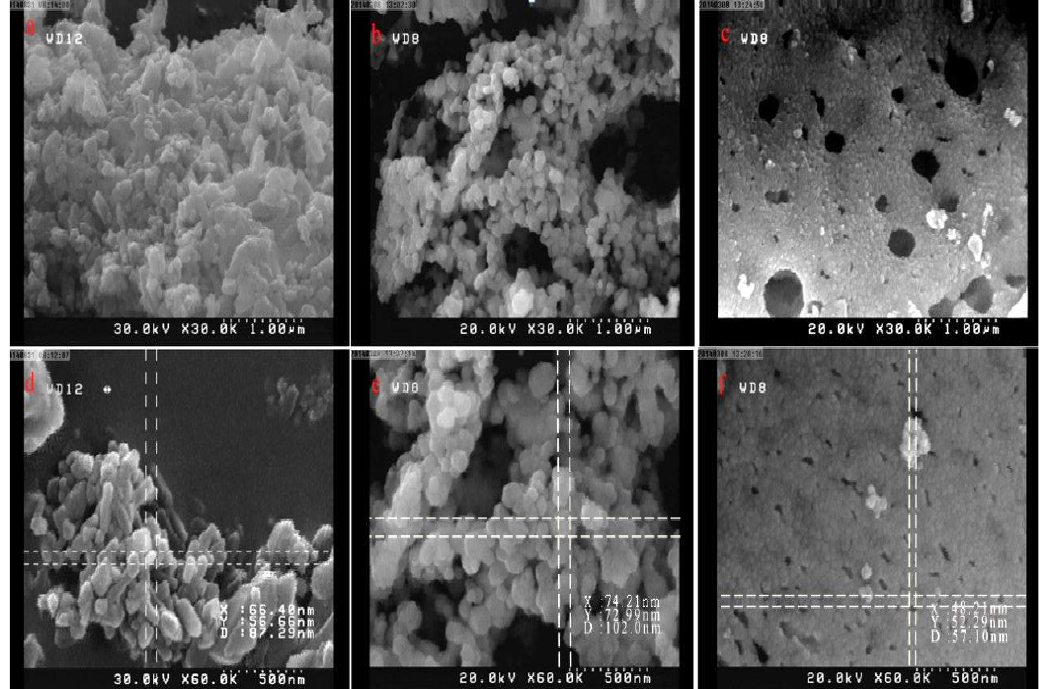
Fig. 7. FESEM pictures of FeO (A & D), Co